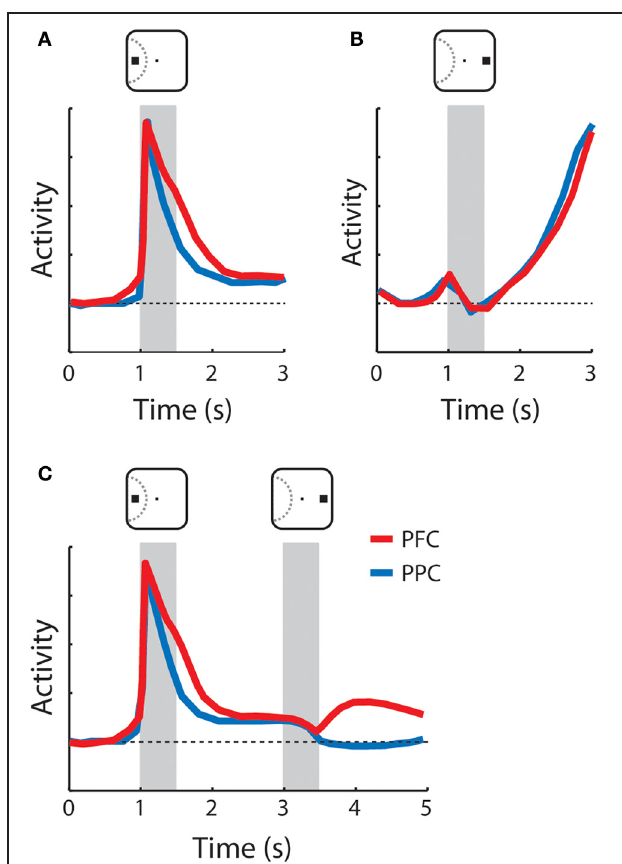
FIGURE 3 | Schematic illustration of neuronal responses with persistent activity in the prefrontal and posterior parietal cortex. Gray bars indicate times of stimulus presentations. Red and blue lines represent the activity of the prefrontal cortex and the posterior parietal cortex, respectively. Insets above the gray bars illustrate examples of stimulus location relative to the receptive field depicted with dotted curve. (A) Sustained activity following appearance of the cue in the receptive field. Both the prefrontal and posterior parietal cortex continuously sustained activity higher than the baseline (horizontal dotted line) after the cue offset. (B) Anticipatory activity following appearance of the cue out of the receptive field. No activity was elicited by the stimulus; activity accelerated during the delay period. (C) Responses to the cue in the receptive field followed by a non-match stimulus out of the receptive field. Prefrontal neurons maintained activity during the delay period after the second stimulus (distractor) was presented whereas the activity of the posterior parietal went back to baseline. The diagrams were constructed based on the results of Qi and colleagues [Qi et al.